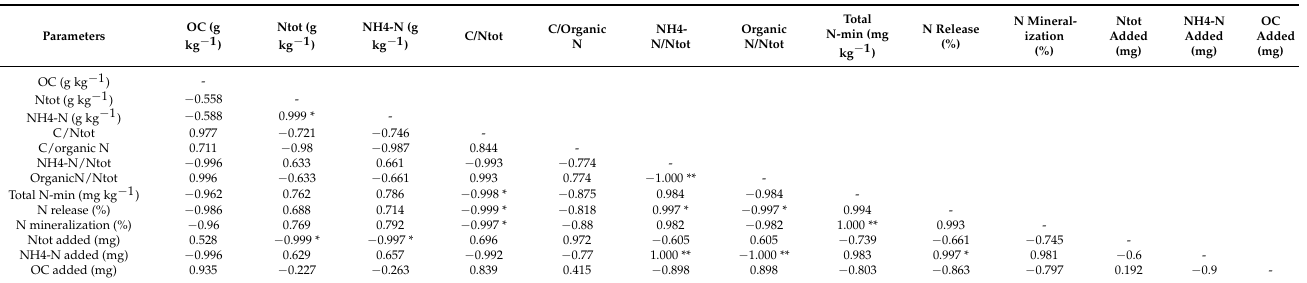
Table A1. Pearson correlation analysis between different parameters in relation to the BBFs, N release, and N mineralization dynamics ( n =